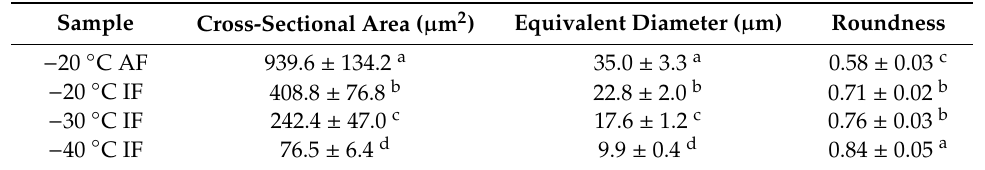
Table 2. Microscopic analysis of ice crystals in samples frozen by conventional air freezing (AF) and immersion freezing (IF) at − 20, − 30, and − 40 ◦ C.